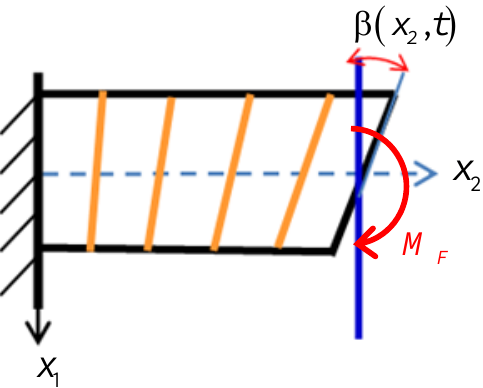
M . Figure 6. Shear deformation of the proof mass caused by the bending moment M F . F